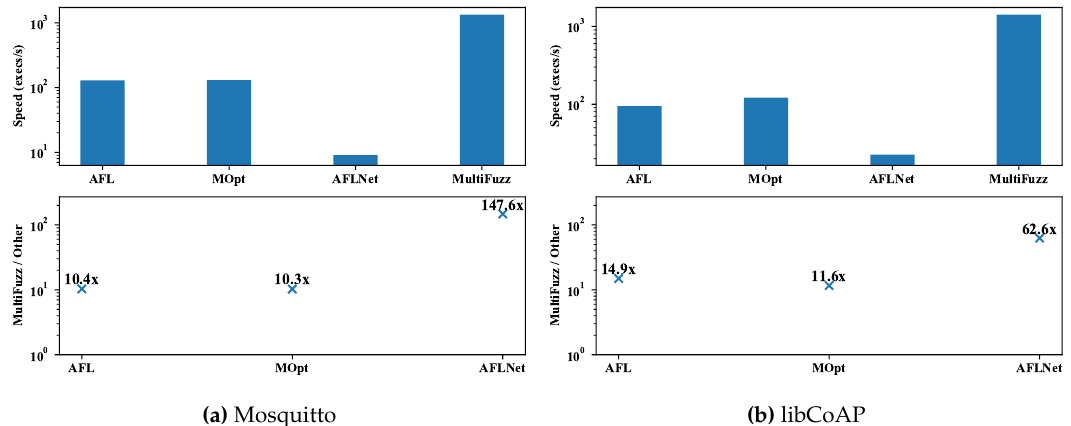
Figure 11. The execution speeds of different fuzzers, and the comparisons of MultiFuzz to other